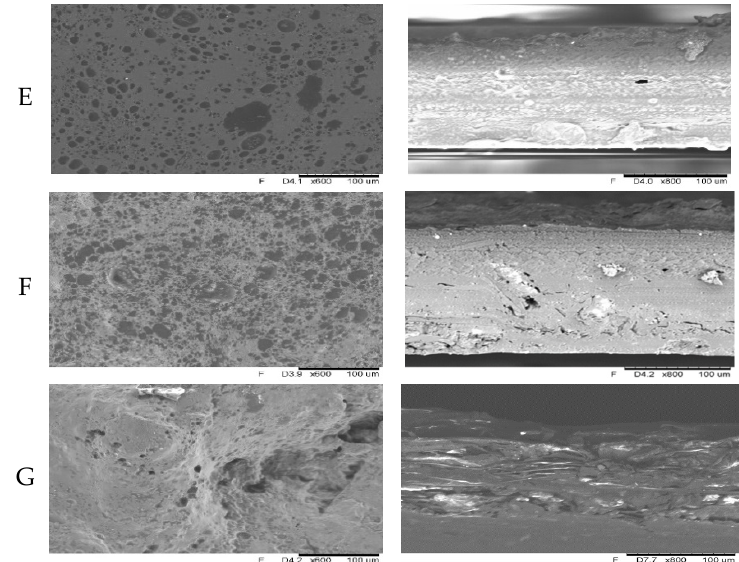
Figure 3. Film micrographs of surfaces and cross-sections of soy protein isolate–oilseed flour films ( A —SPI, B —SPI_Flaxseed, C —SPI_Hempseed, D —SPI_Sesameseed, E —SPI_Sunflowerseed, F —SPI_Evening_primroseseed, G —SPI_Pumpkinseed).